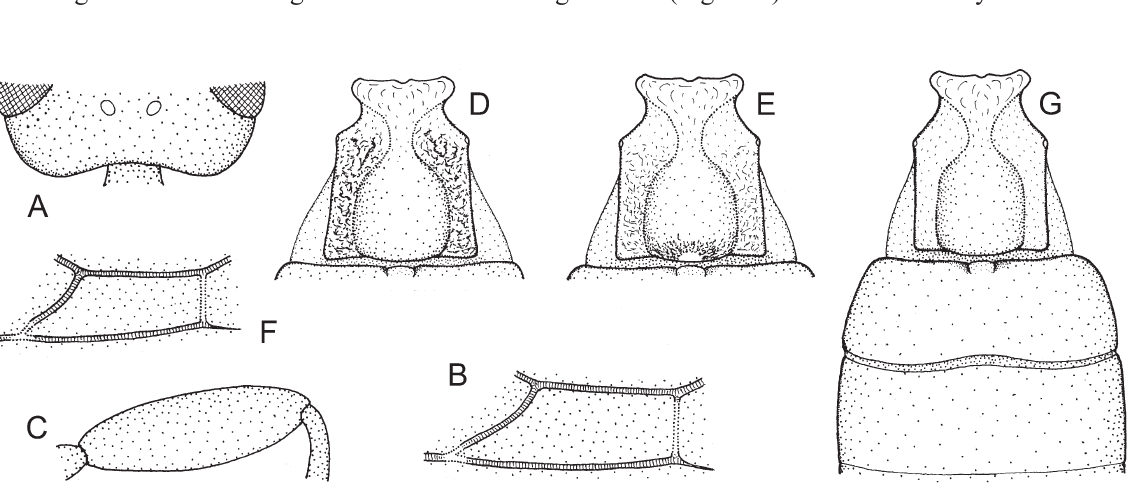
Fig. 49. Bracon ( Glabrobracon ) terebella Wesmael, 1838 (A-E: ♀, F-G: ♂). A . Hind half of head in dorsal view. B . Second submarginal cell of right forewing. C . Hind femur. D-E . First tergite. F . Second submarginal cell of right forewing. G . Tergites